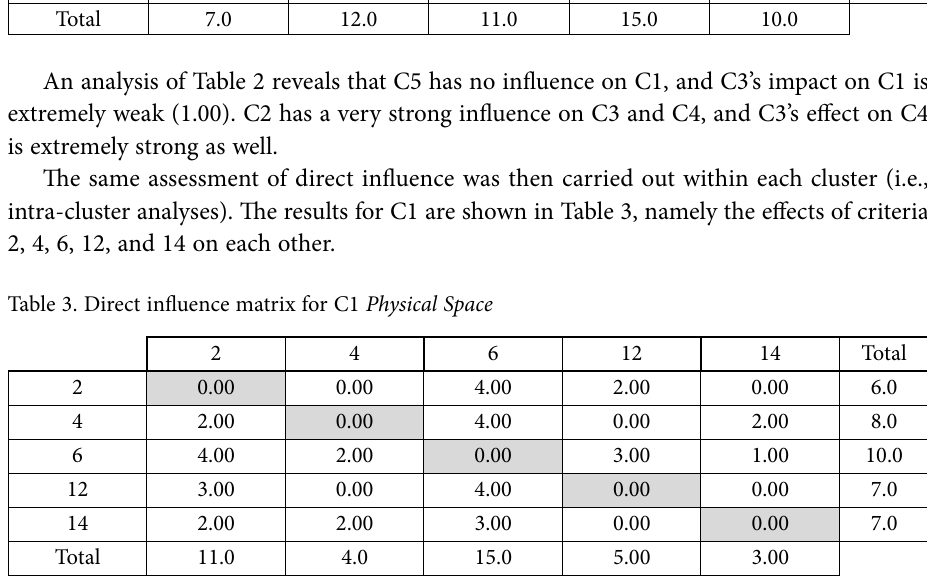
Table 3 highlights the importance of criterion 6 in terms of its total influence score. In addition, criterion 12 strongly influences criterion 6 (4.00), and criterion 2 has a heavy im- pact on criterion 6